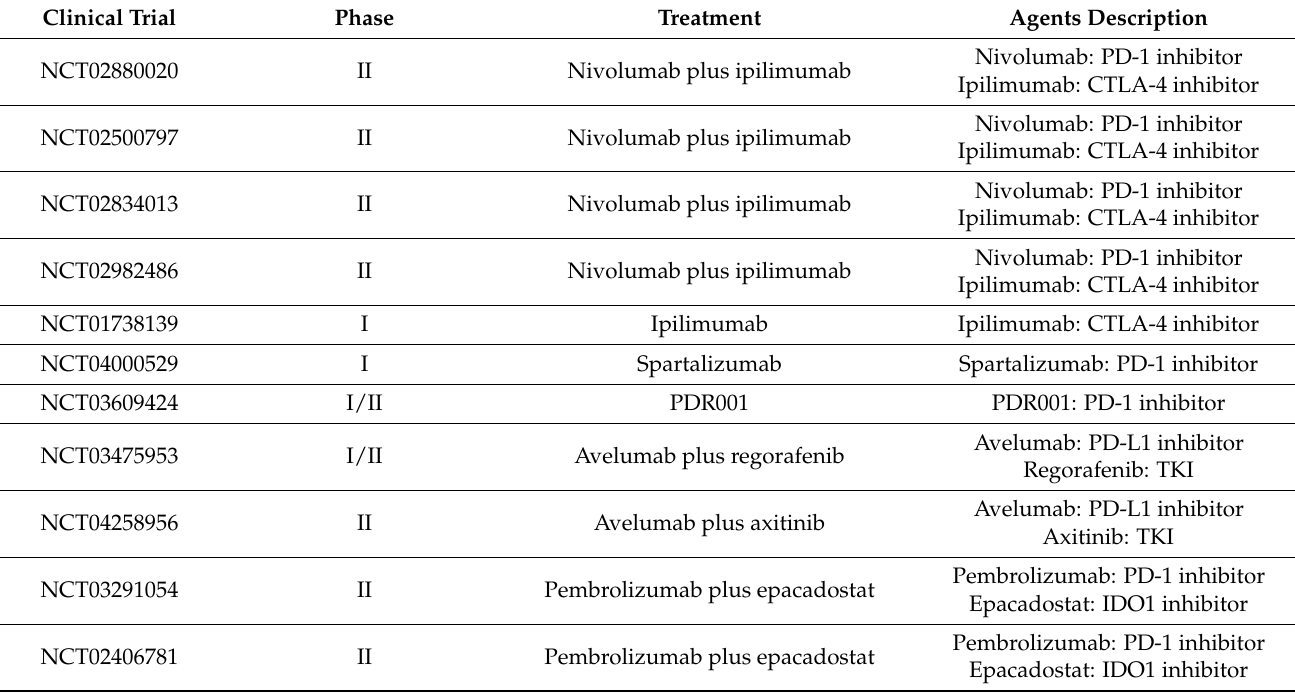
Table 1. Ongoing clinical trials evaluating immunotherapy in